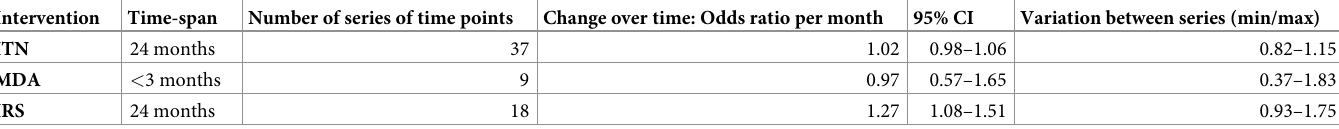
Table 5. Estimated changes in the proportion of patent infections that were P. vivax over time for each intervention separately, adjusted for season at time-point of survey. Intervention